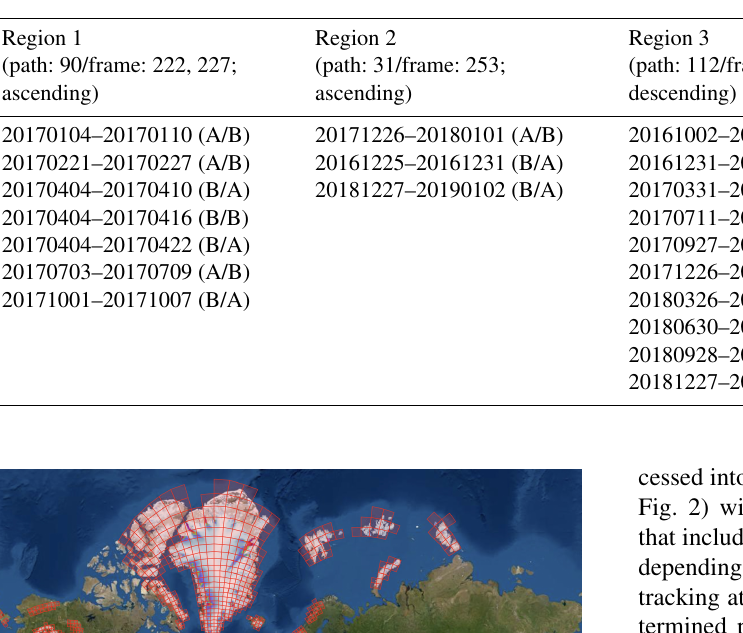
Table 3. Sentinel-1 image pairs used for validation of the algorithms. All image pairs were acquired with the interferometric wide swath (IW) single look complex (SLC) mode. Only HH-pol is used. The pixel spacing is 3.67m in ground range and 15.59m in azimuth. The parenthesis of “(A/B)” denotes the Sentinel-1A image was acquired prior to the Sentinel-1B image, and vice versa.